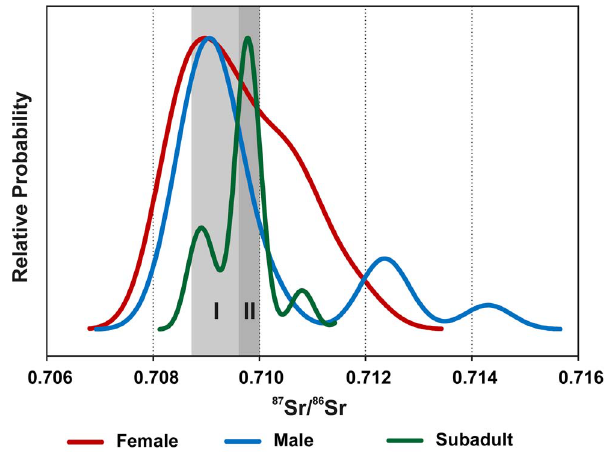
Figure 5. Kernel density plot of the 87 Sr/ 86 Sr ratios of the enamel of male and female adults and subadult individuals from the Lombard cemetery at Szo´la´d (graphics: C. Knipper).